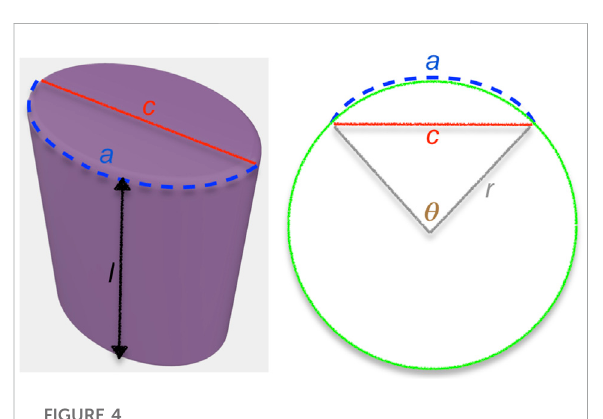
FIGURE 4 Approximation of the body part as an elliptical cylinder.